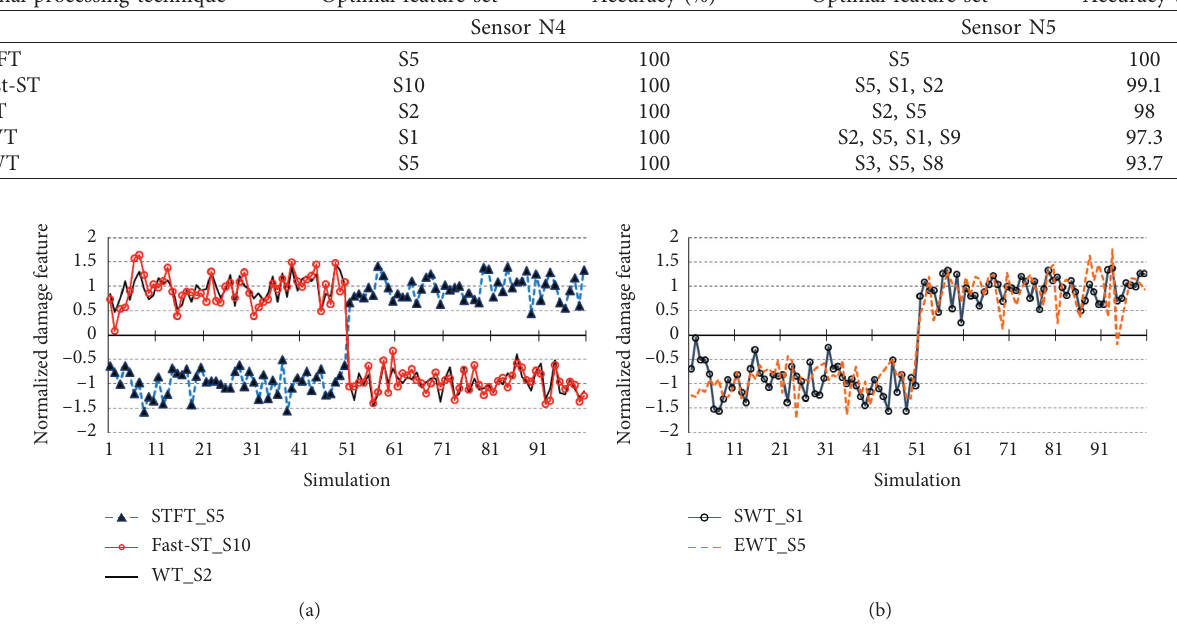
Figure 3: Normalized damage feature for case B. (a) The features extracted by using STFT, fast-ST, and WT methods and (b) the features extracted by using SWT and EWT. Table 4: Classification accuracy of the selected feature subset obtained by using different feature extraction methods for bridge health monitoring benchmark problem (case C).